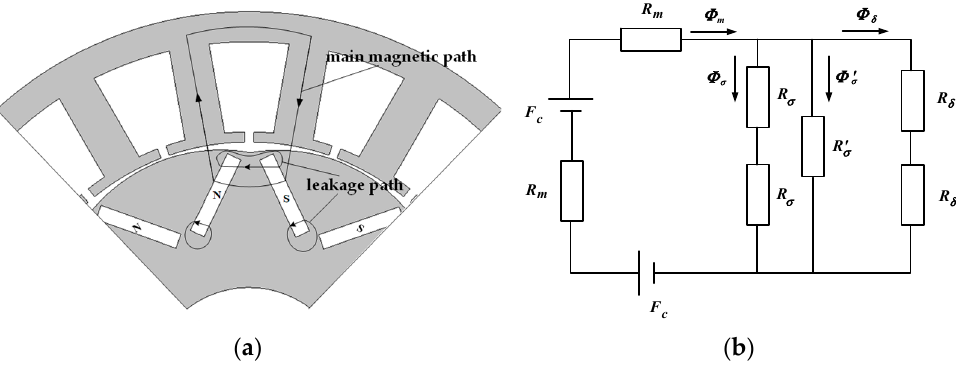
Figure 6. ( a ) Schematic diagram of magnetic flux lines path. ( b ) Equivalent magnetic circuit model.